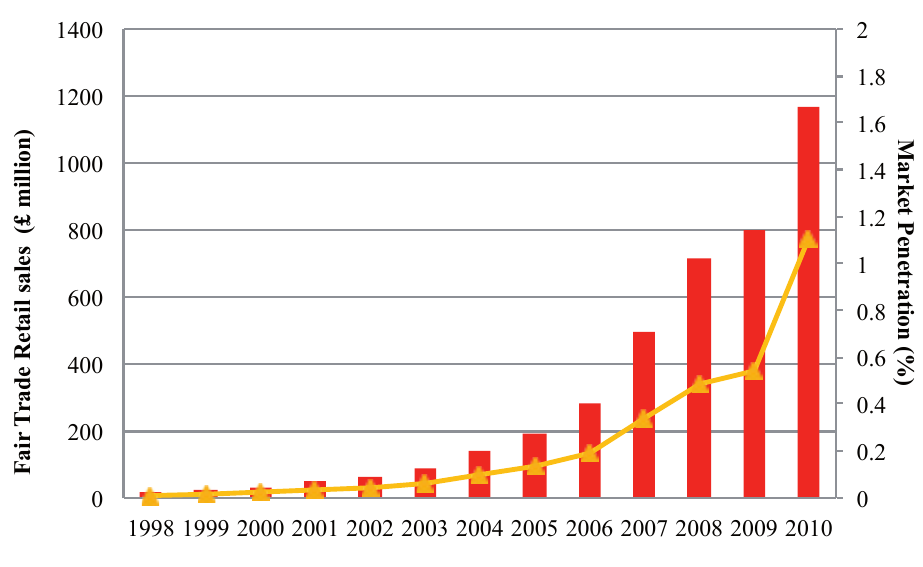
Figure 5. Fair trade sales and market penetration of fair trade in the UK (mio £,